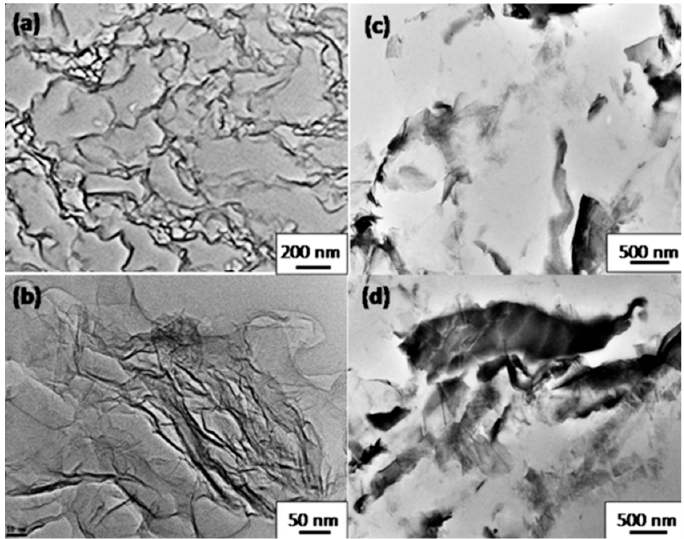
Figure 20. High resolution transmission electron microscope images of well-dispersed GnPs ( a , b ); and poorly-dispersed GnPs ( c , d ) in the PLA matrix. The graphene concentration in each figure was 0.56 vol% [78].